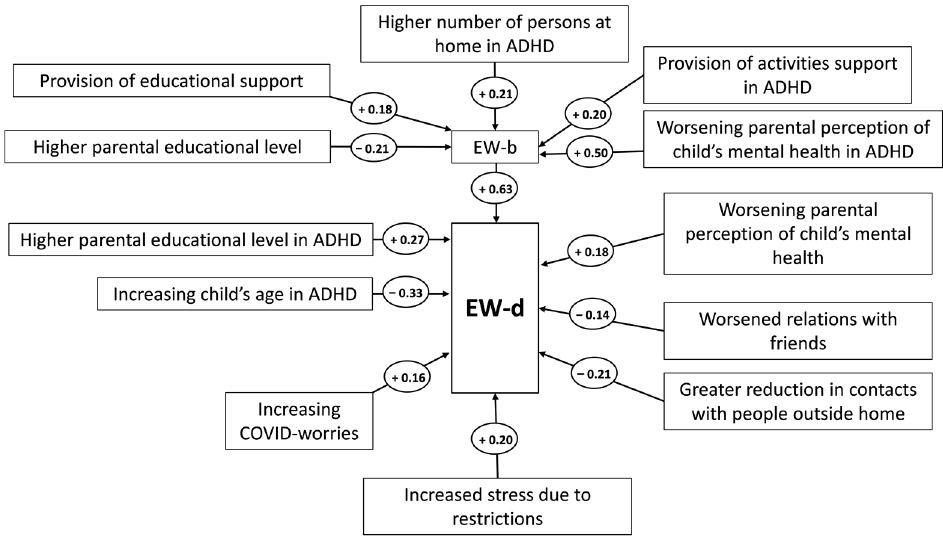
Figure 2. Best-fitting SEM. Effects are represented by connecting arrows with accompanying signs describing the nature of the relation (+ for positive association, − for negative association).